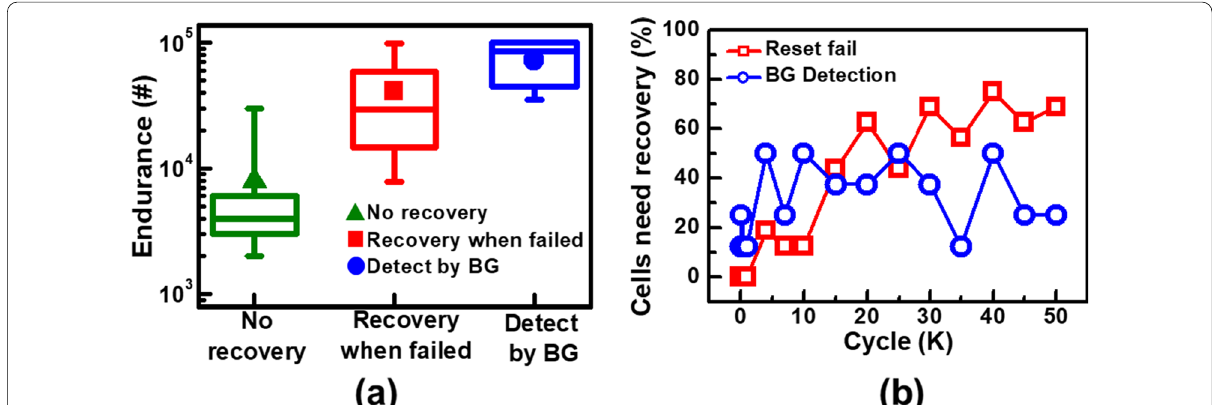
Fig. 11 a Endurance comparison of different techniques, including recovery reset treatment and BG circuit detection. b Number of cells experienced recovery reset treatment during